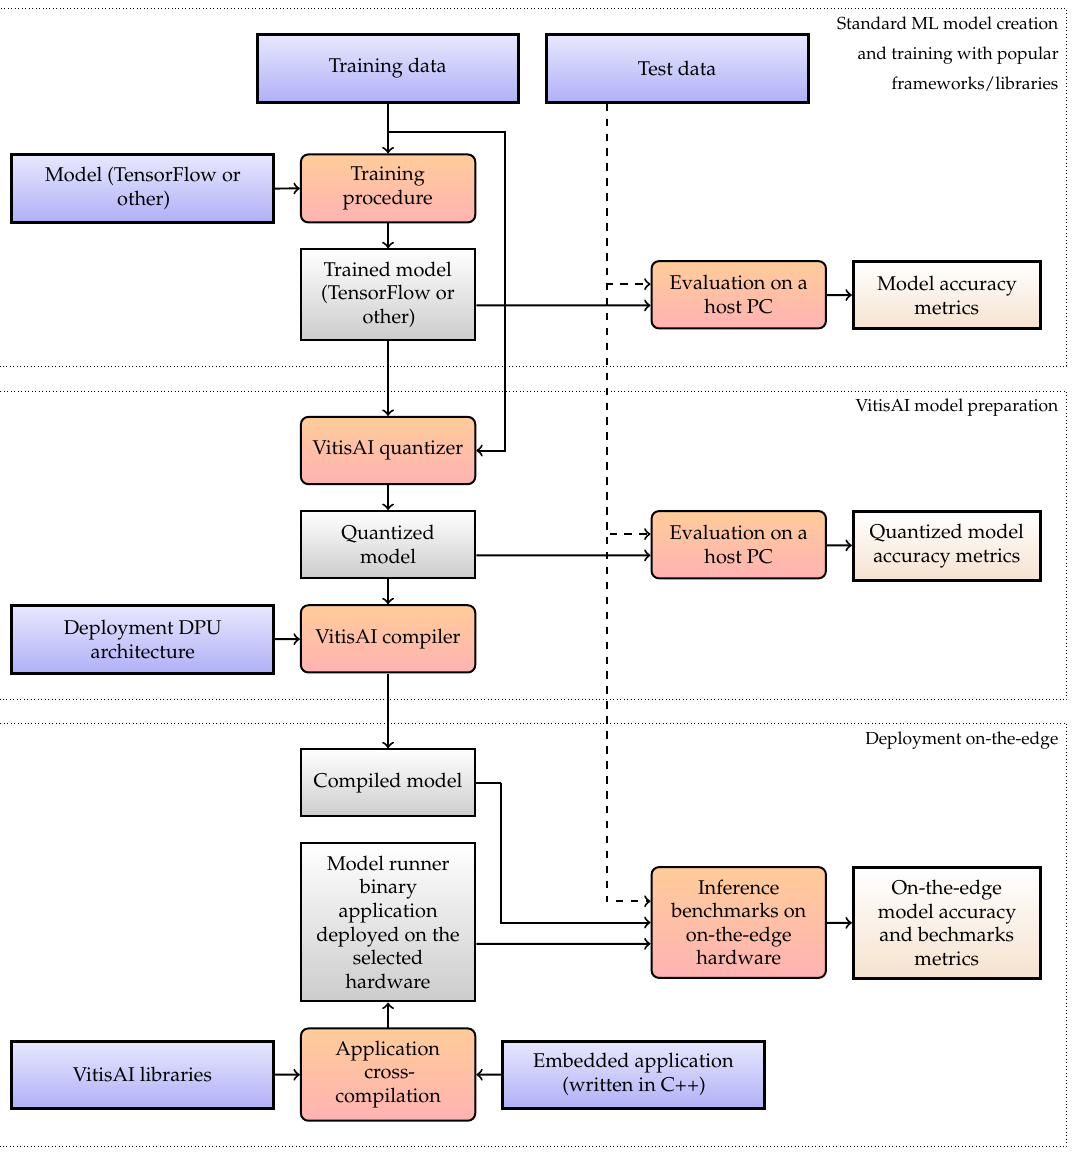
Figure 4. Deployment pipeline of an AI model on an embedded device with Xilinx’s Vitis AI (nodes are color-coded: blue for inputs, red for actions, gray for artifacts, and yellow for results; some connections are dashed for visual